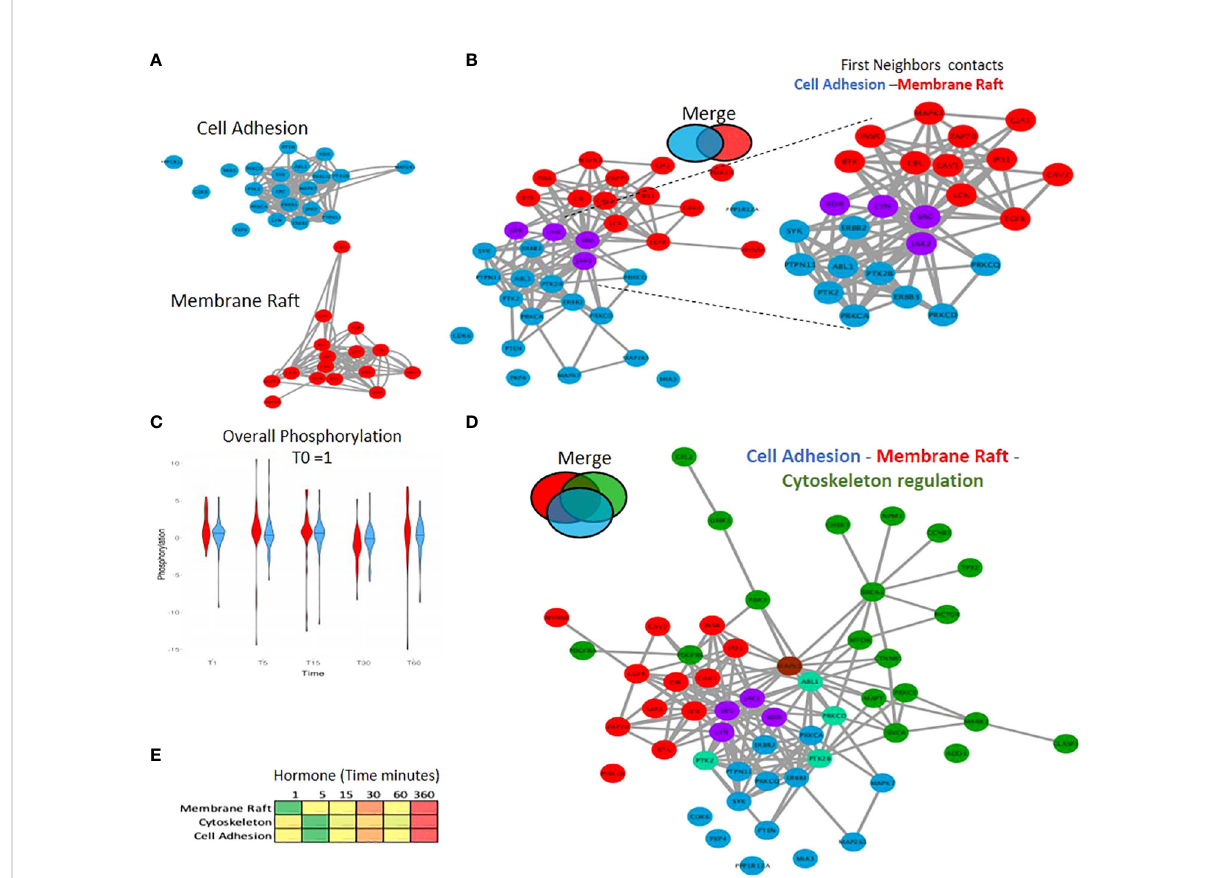
FIGURE 5 Combining PPI networks from distinct cellular compartments reveals a coordinated crosstalk. (A) PPI network showing the signi fi cantly regulated phosphorylated proteins located in cell adhesion (blue) and the membrane raft (red) identi fi ed in response to hormone. (B) Merge of the cell adhesion network (A) blue and membrane raft network (A) red. The two networks connect based on known PPI however no protein was identi fi ed as annotated in both sets. This integration of the two networks is highlighted (right panel) where proteins from each network were selected based on having a fi rst neighbor with a protein of the other network. (C) Violin plot showing the average phosphorylation of proteins over time in response to hormone within the membrane raft or cell adhesion networks. Data is normalised to time 0 = 1. (D) Merge of Cell Adhesion-Membrane (B) and the cytoskeleton networks. The two networks are merged based on known PPI. Proteins annotated in more than one function are colored based on the Venn diagram (i.e. cytoskeleton and cell Adhesion; light green, membrane raft and cytoskeleton; brown). (E) Heatmap showing the average phosphorylation of all proteins within each network in response to hormone over time, showing the activation of the membrane raft fi rst at 1 minute followed by the cytoskeleton and cell